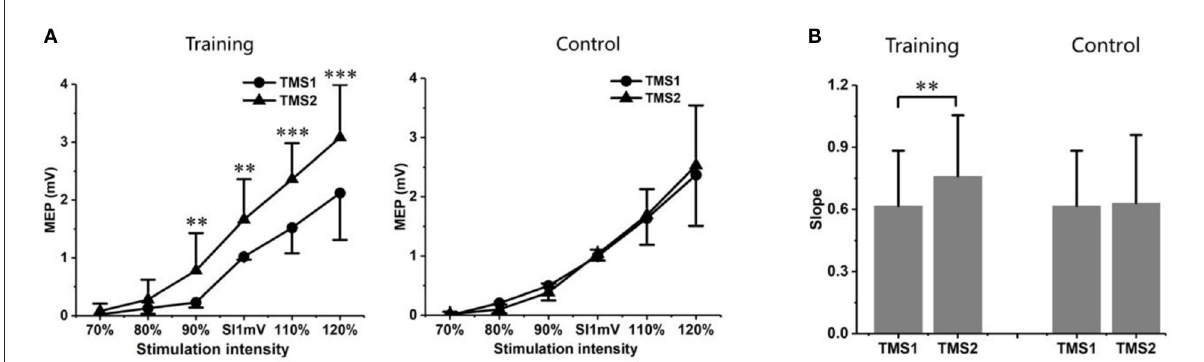
FIGURE10 (A) IO curves measured MEPs in the FDI muscle as a function of magnetic stimulation intensity before (Day 0: TMS1, marked as solid circle •) and after (Day 8: TMS2, marked as solid triangle N ) motor practice for training (left) and control (right) groups, respectively. Significant MEPs differences were found between TMS1 and TMS2 measurements within the training group, while no statistical differences were found between the two MEPs measurements in control group. (B) The slopes of the IO curve were obtained within the approximately linear part (90–120% of SI1mV) . The statistical differences were also found within the training group, indicating the effect on the descending motor pathway caused by training. Significant level: ** p < 0.01 and *** p <